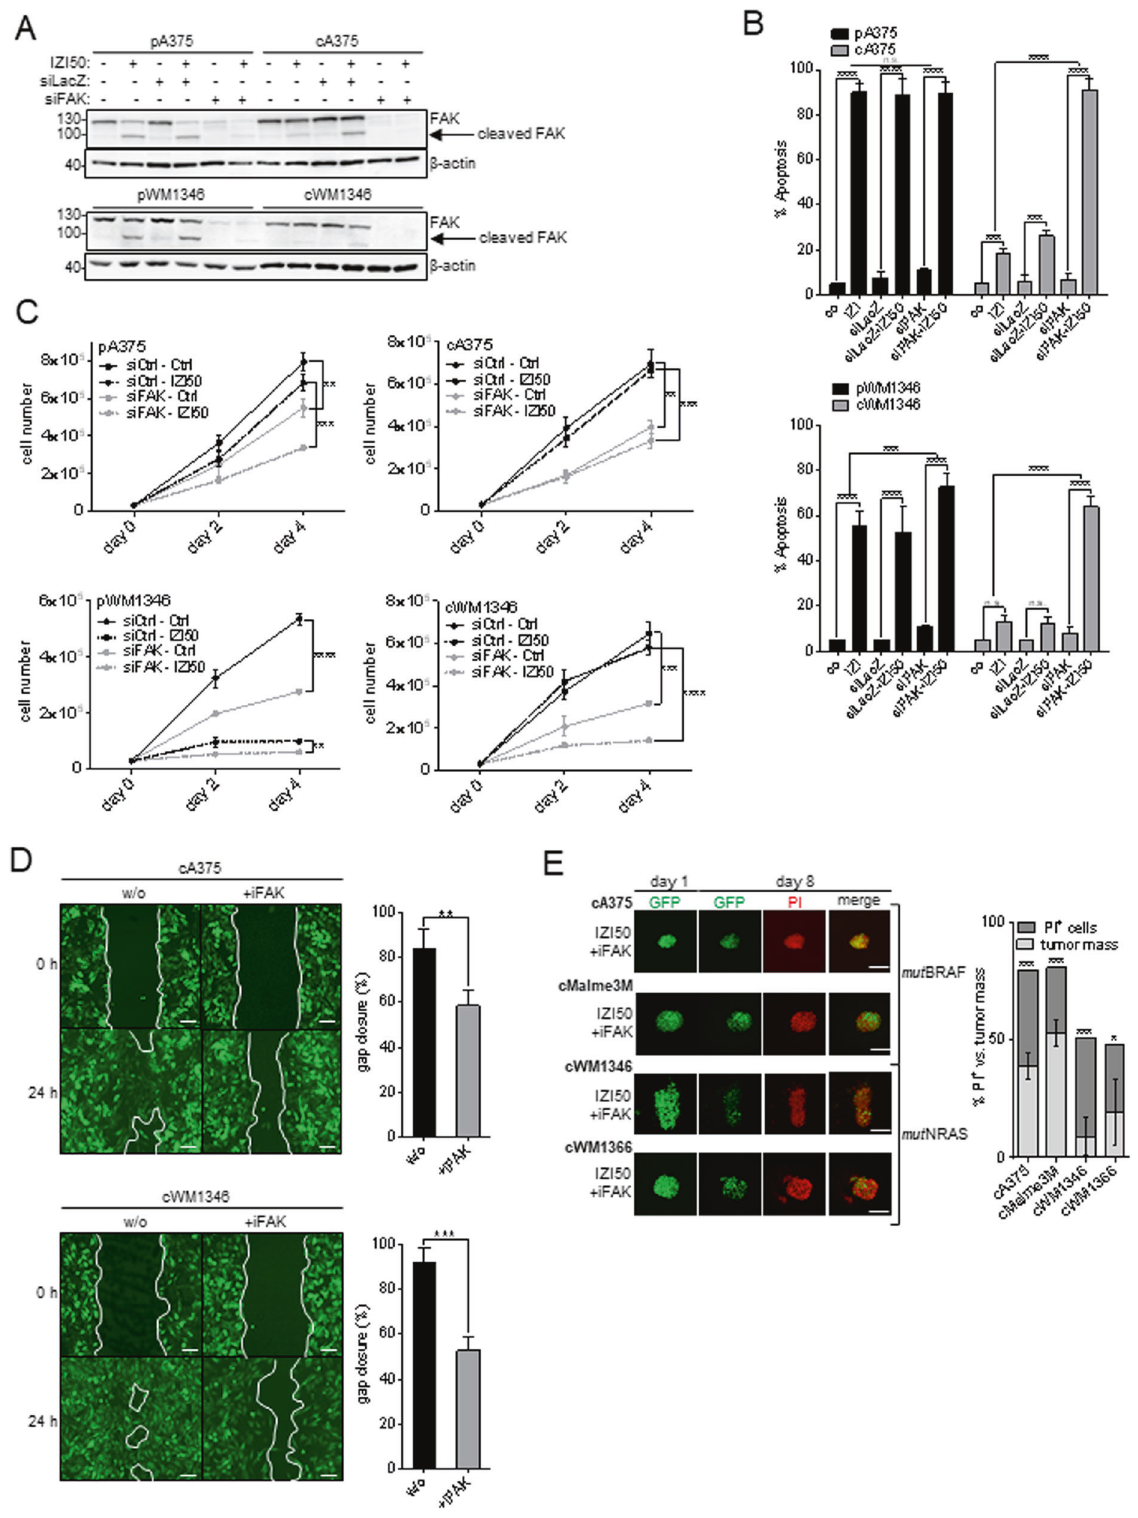
3D melanoma spheroids Melanoma spheroids were generated using the “ hanging drop ” method [24]. Brie fl y, (4 – 20) × 10 4 GFP-expressing melanoma cells were resus- pended in 5 ml of RPMI containing 20 – 40% methocell, depending on cell line. 40 drops of 25 µl containing 200 – 1000 cells were spotted on the lid of